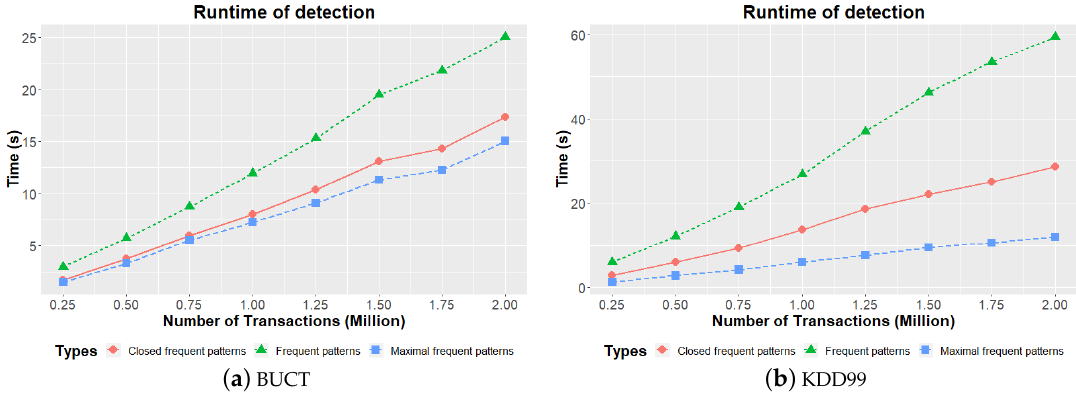
Figure 2. Runtime of detection.